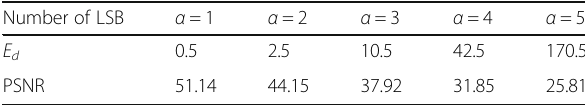
Table 1 Approximate PSNR value of the watermarked image under different number of the